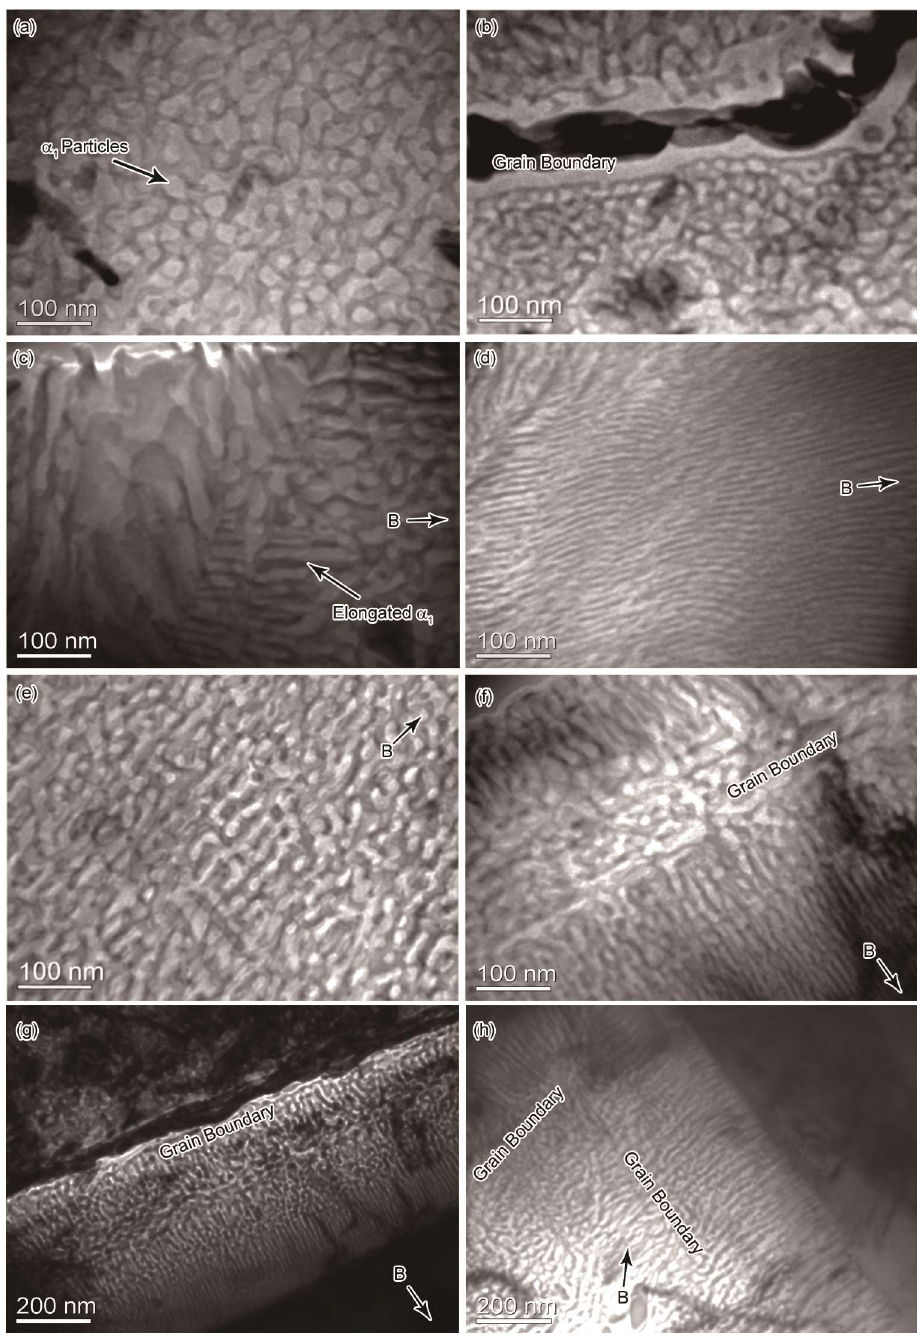
Figure 3. TEM image of the Fe ‐ Cr ‐ Co alloy after thermomagnetic treatment and step aging: Annealed without magnetic field, inside a grain ( a ) and near a GB ( b ), respectively; annealed in a 1 T magnetic field, rod ‐ like α 1 particles ( c ) and feather ‐ like structure ( d ), respectively; annealed in a 12 T magnetic field, inside a grain ( e ) and near a GB ( f ), respectively. ( g ) and ( h ) show a long GB and a GB at the grain corner in the 12 T sample, respectively.